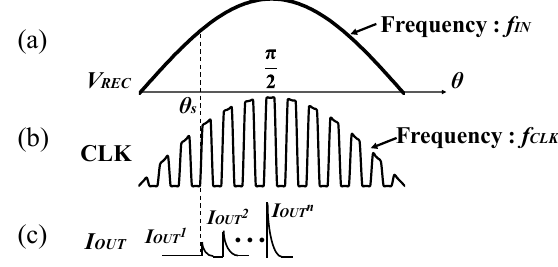
Figure 6. Waveform of the clocked AC-DC CP: ( a ) V REC , ( b ) CLK, ( c ) I OUT .